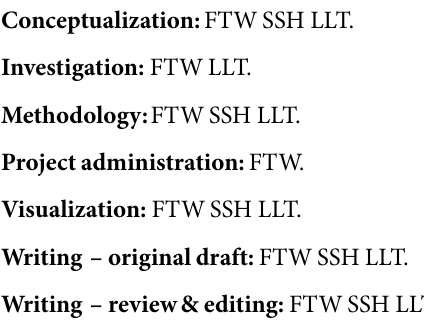
S5 Fig. Size exclusion column chromotagraphy of 2:1 bi-SdyCatcher to triSdyTag ligation reaction. The elution time for the different mass standards are also annotated. Indicated peaks have the masses: (1) > 669 kDa, (2) ~300 kDa, (3) ~210 kDa, (4) ~150 kDa, (5) ~100 kDa and